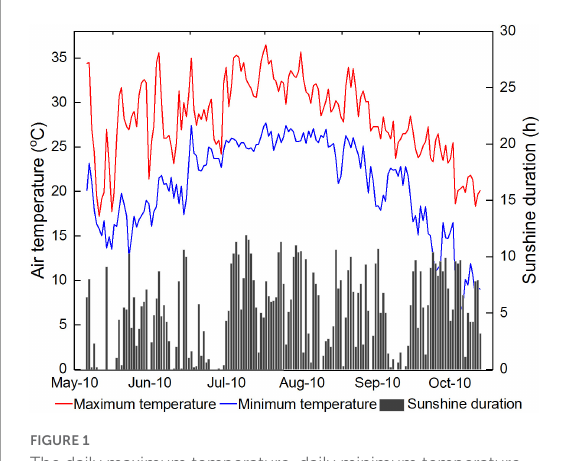
FIGURE1 The daily maximum temperature, daily minimum temperature and daily sunshine duration during rice sowing and full-ripening period in the year of